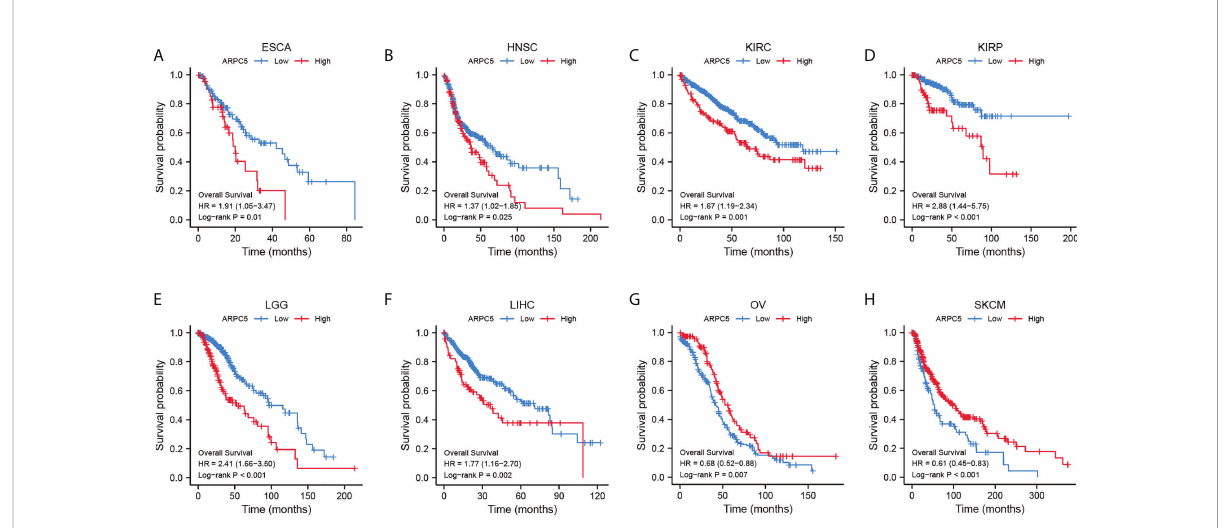
FIGURE 4 ARPC5 expression signi fi cantly correlated with OS based on Kaplan – Meier analysis. (A) The correlation in ESCA. (B) The correlation in HNSC. (C) The correlation in KIRC. (D) The correlation in KIRP. (E) The correlation in LIHC. (F) The correlation in LGG. (G) The correlation in OV. (H) The correlation in SKCM. The optimal cutoff of ARPC5 expression were used to divide patients into high- and low-expression